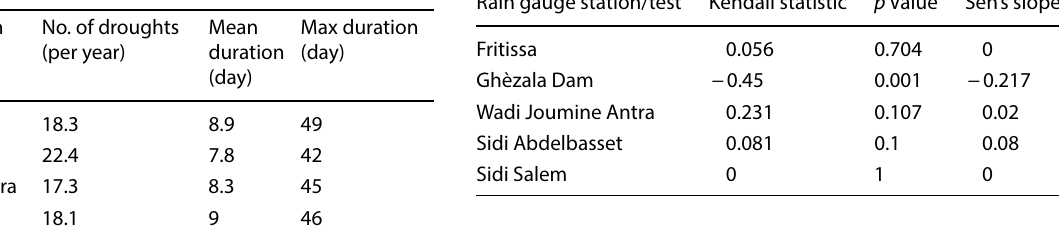
Table 8 Trends test thresholds for the annual number of dry spells. Level of significance alpha threshold = 0.05 Rain gauge station/test